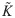
Testing the shape-dependence of our adaptation of Ripley’s K-function using repeated random decimation of simulated fields of view.Note that the black circular regions (black pixels) are considered to be outside the study region, and are generated to create artificial “edges”. Panel A: Sample simulated fields of view at decimation frequencies of 4, 6, 10 and 12. Panel B: The normalized and centered K-function (K˜) at various decimation frequencies. The black line represents the mean K˜ and the dotted lines represent the upper and lower critical quantiles (Q01 and Q99). Each mean/quantile was determined using a set of 1000 simulations. It can be seen that K˜ remains centered on zero regardless of the decimation frequency or radius at which K˜ was calculated.